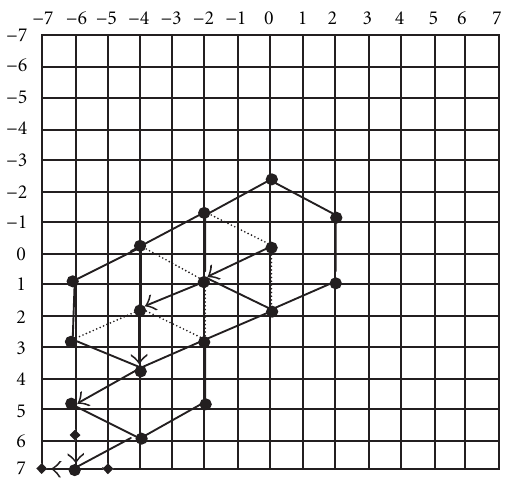
Figure 4: HS search path for MV ( − 7 ,